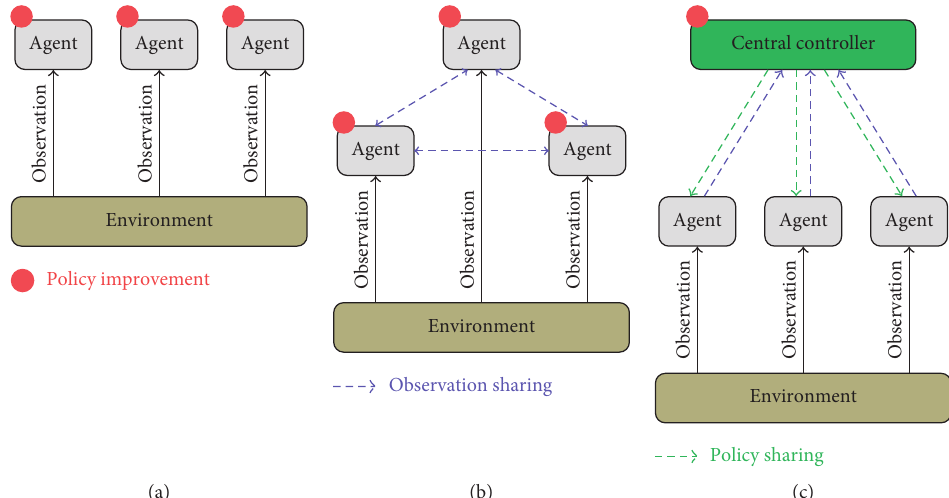
Figure 6: Cooperation concepts of multiagent learning systems. (a) Full local learning. (b) Knowledge sharing. (c) Centralized learning.